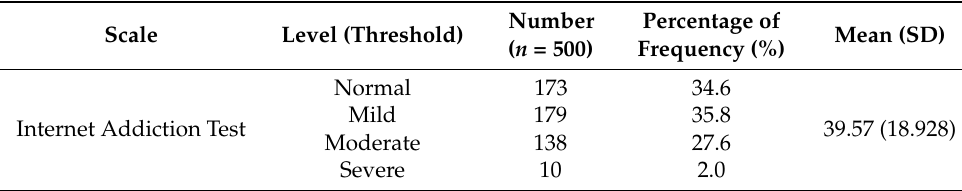
Table 4. Participants’ results to different